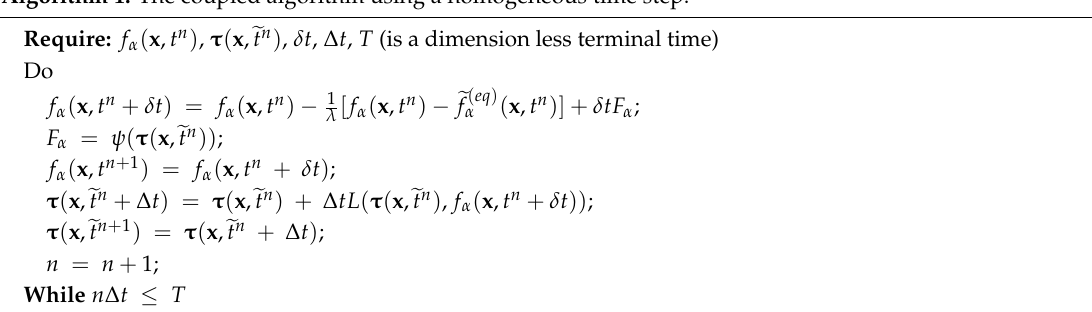
Algorithm 1. The coupled algorithm using a homogeneous time